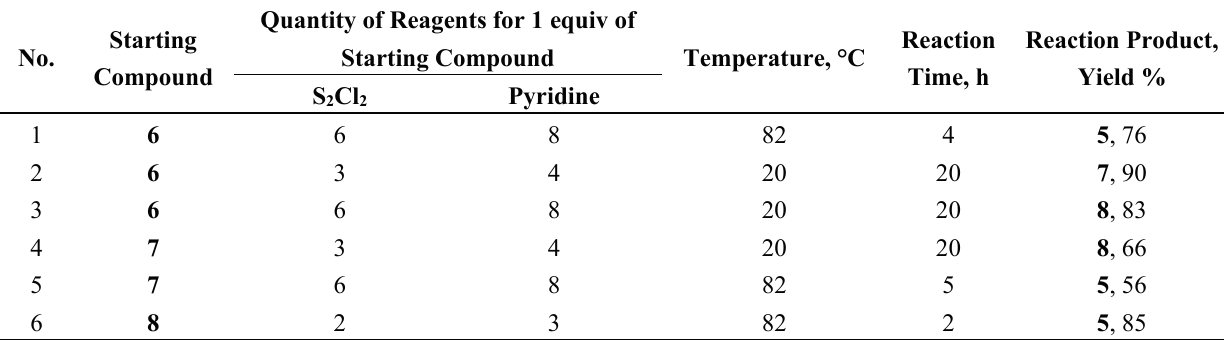
Table 1. Reactions of [1,2,5]oxadiazolo[3,4- b ]pyrazines 6 – 8 with S 2 Cl 2 in